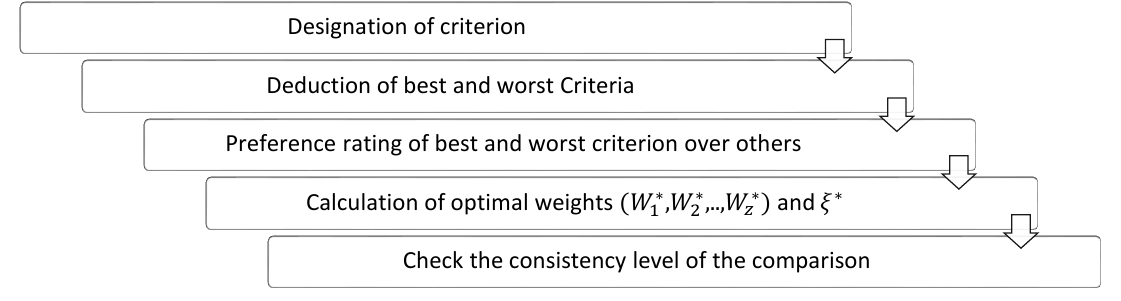
Figure 2. Best – worst method steps. Figure 2. Best–worst method